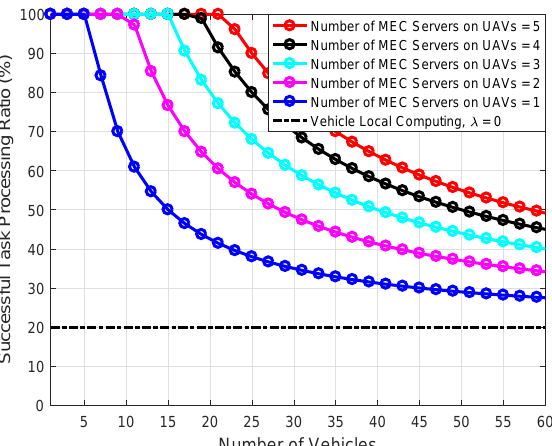
Figure 10. Comparison of the successful task processing ratio with respect to the number of vehicles under the number of MEC servers on